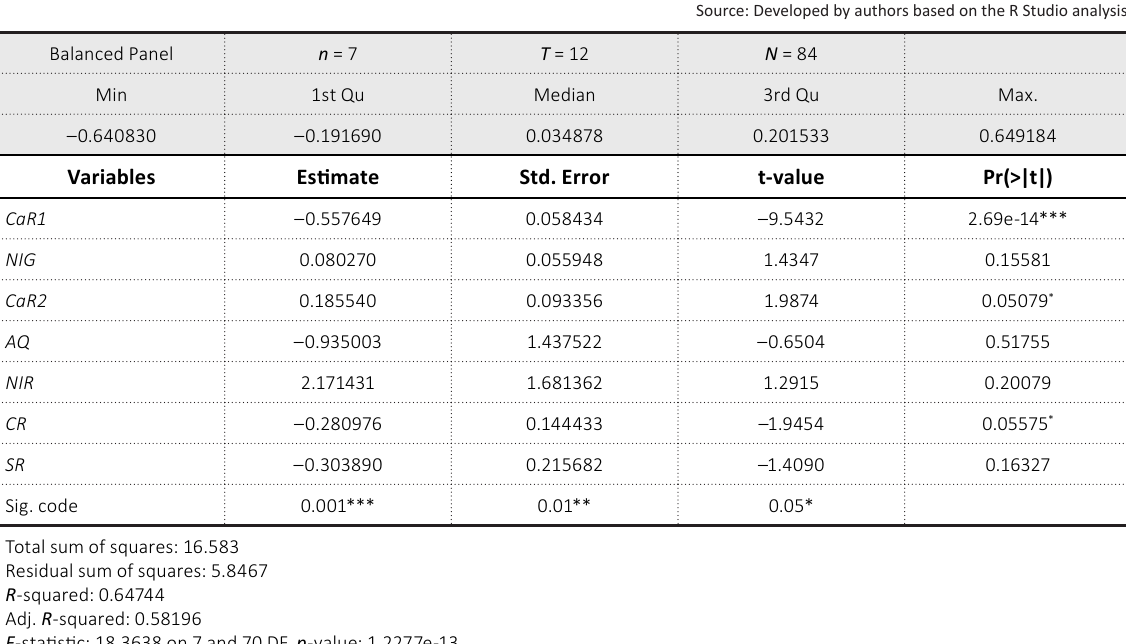
Table 7. Fixed effect regression model on Bank